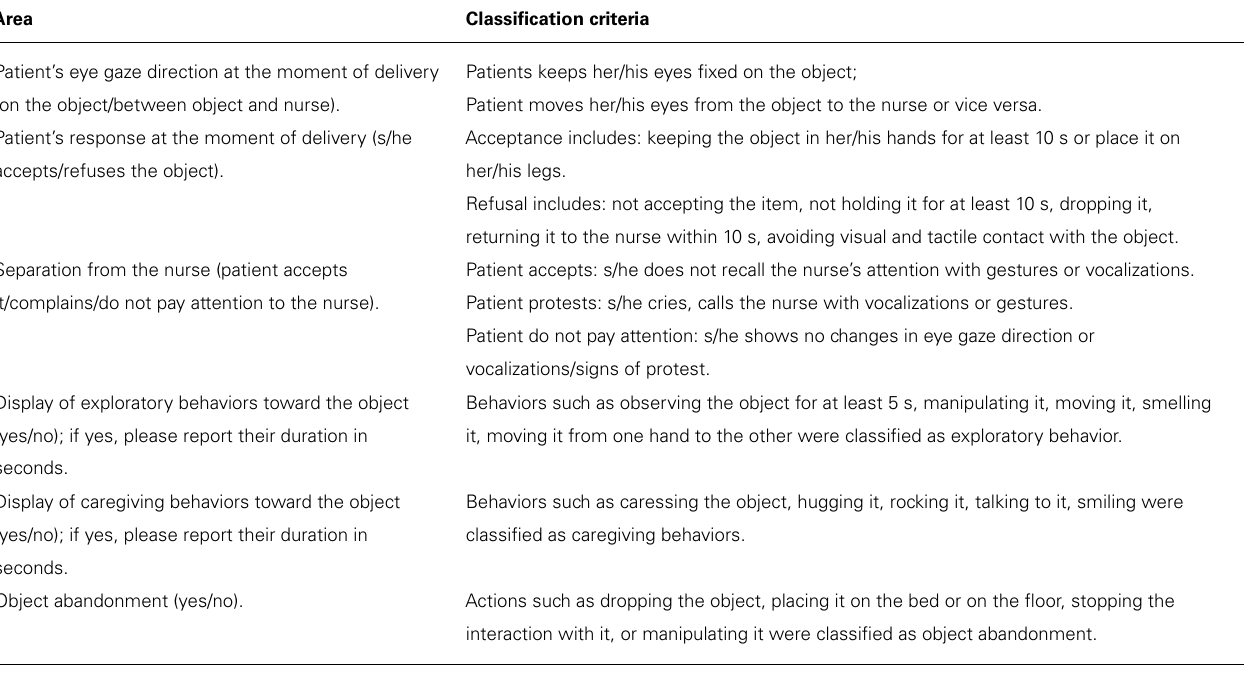
Table 1 | Classification criteria used in the video recording analysis of the protocol. Area Classification criteria